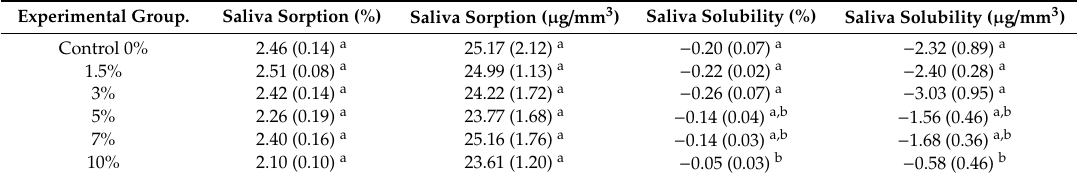
Table 3. Mean and standard deviation values of sorption ( µ g / mm 3 ) and percentage of sorption (%) after 90 days of storage in artificial saliva; solubility ( µ g / mm 3 ) and its percentage (%) values after 180 days. Experimental Group.